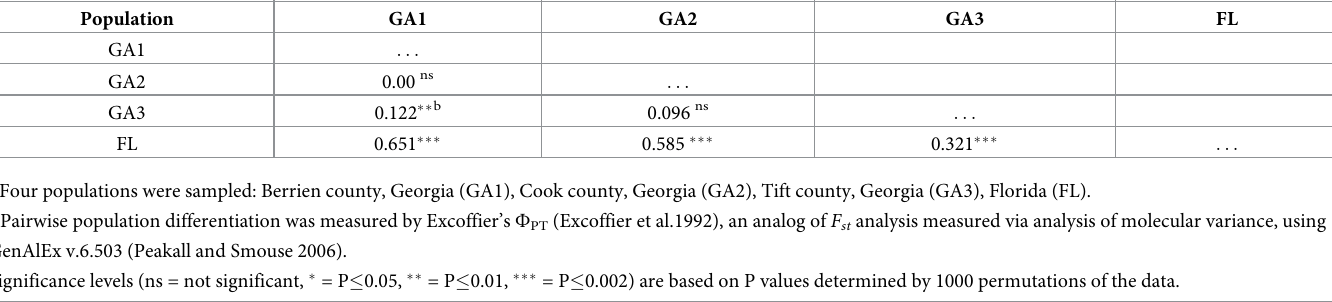
(Table 5). For the PCoA analysis the first and second principal coordinates explained 80.0% and 5.6% of the variance, respectively (Fig 1). The GA isolates belonging to three distinct pop- ulations were clustered together and less diverse. The Florida population, on the other hand, was more diverse. Partitioning of the genetic variation ( Ф ) was performed for the three FON races detected PT (0, 2 and 3). Significant partitioning of the genetic variation by race was not observed (Table 6). Moreover, molecular variance among races accounted for 0% of the variation, while 100% of the variation was observed within the races indicating high diversity within each race (Table 7).